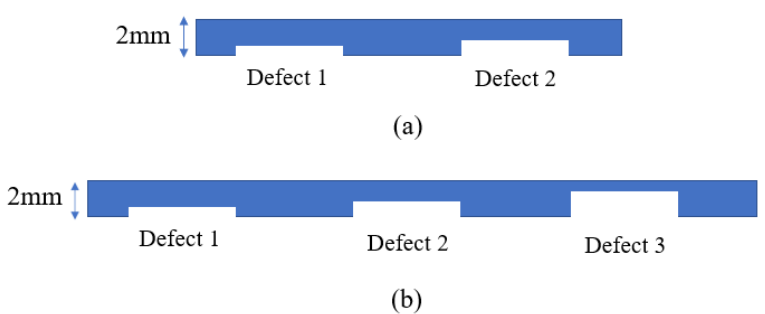
Figure 5. Cross-sectional view of two membranes: ( a ) profiles of defect 1 and defect 2 in Figure 4a; ( b ) profiles of defect 1, 2, and 3 in Figure 4b. Table 5. Dimensional details for defects shown in Figure 4a.